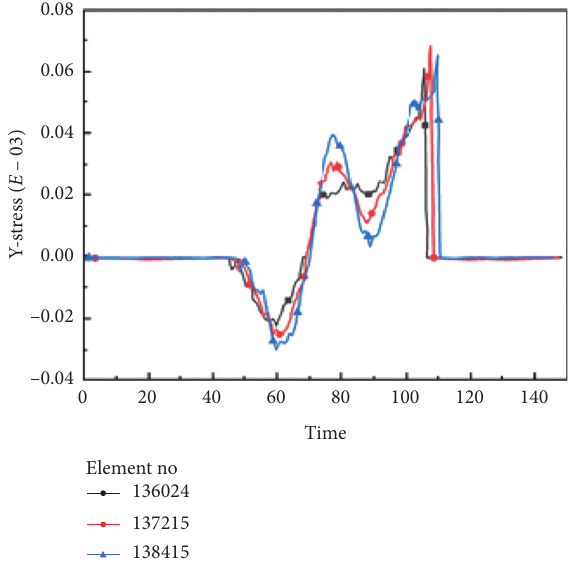
Figure 16: Curve of Y -stress on selected